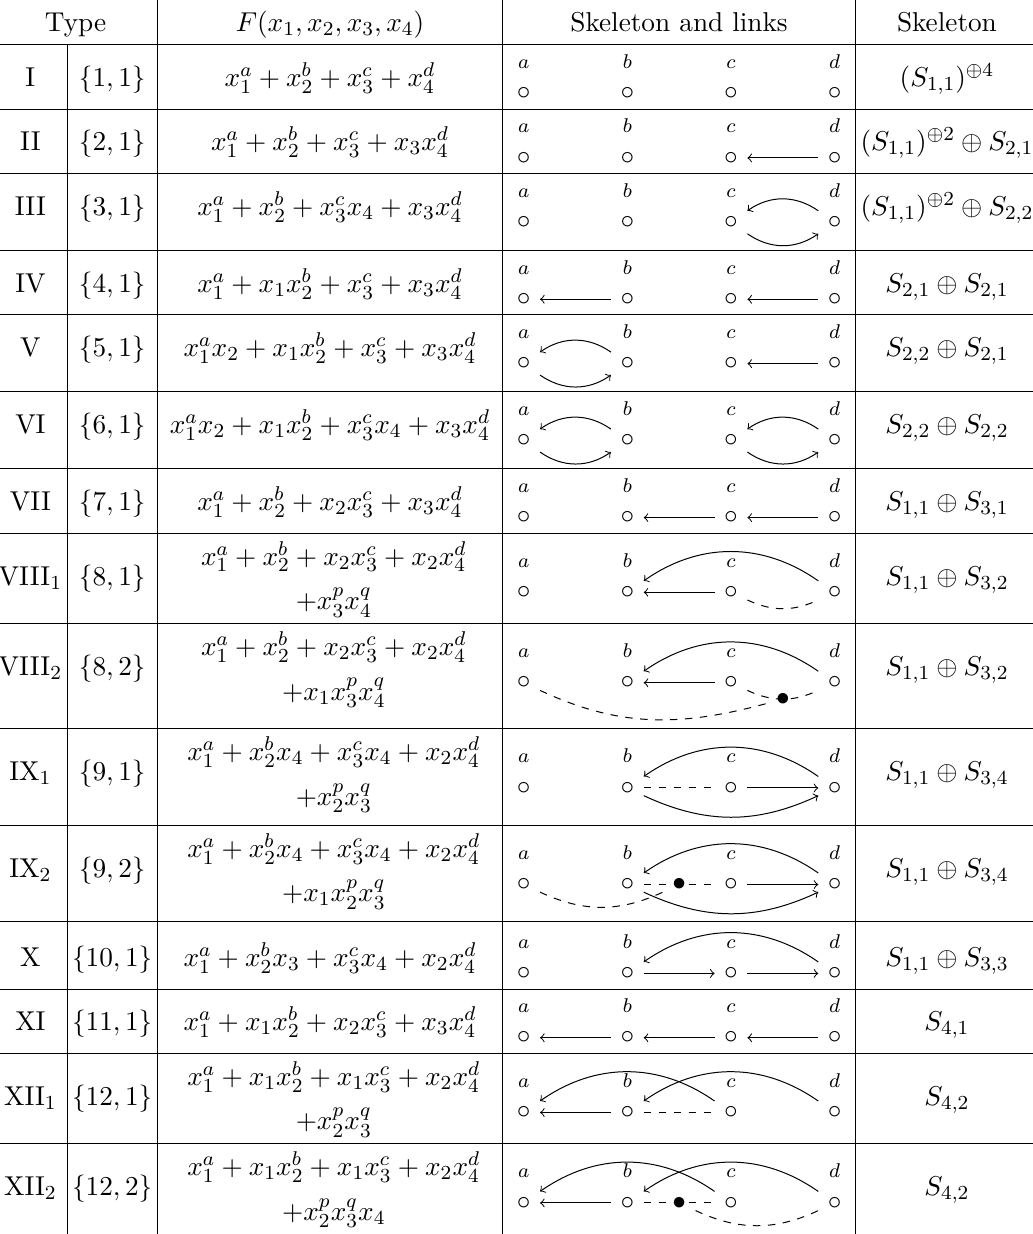
Table 1 . The KS-YY classification of isolated hypersurface singularities in C 4 : types I to XIII. Note that types I–VI exhaust the possibilities using skeleton with up to n = 2 fields, while the cases I–X exhaust the possibilities using skeletons with up to n = 3